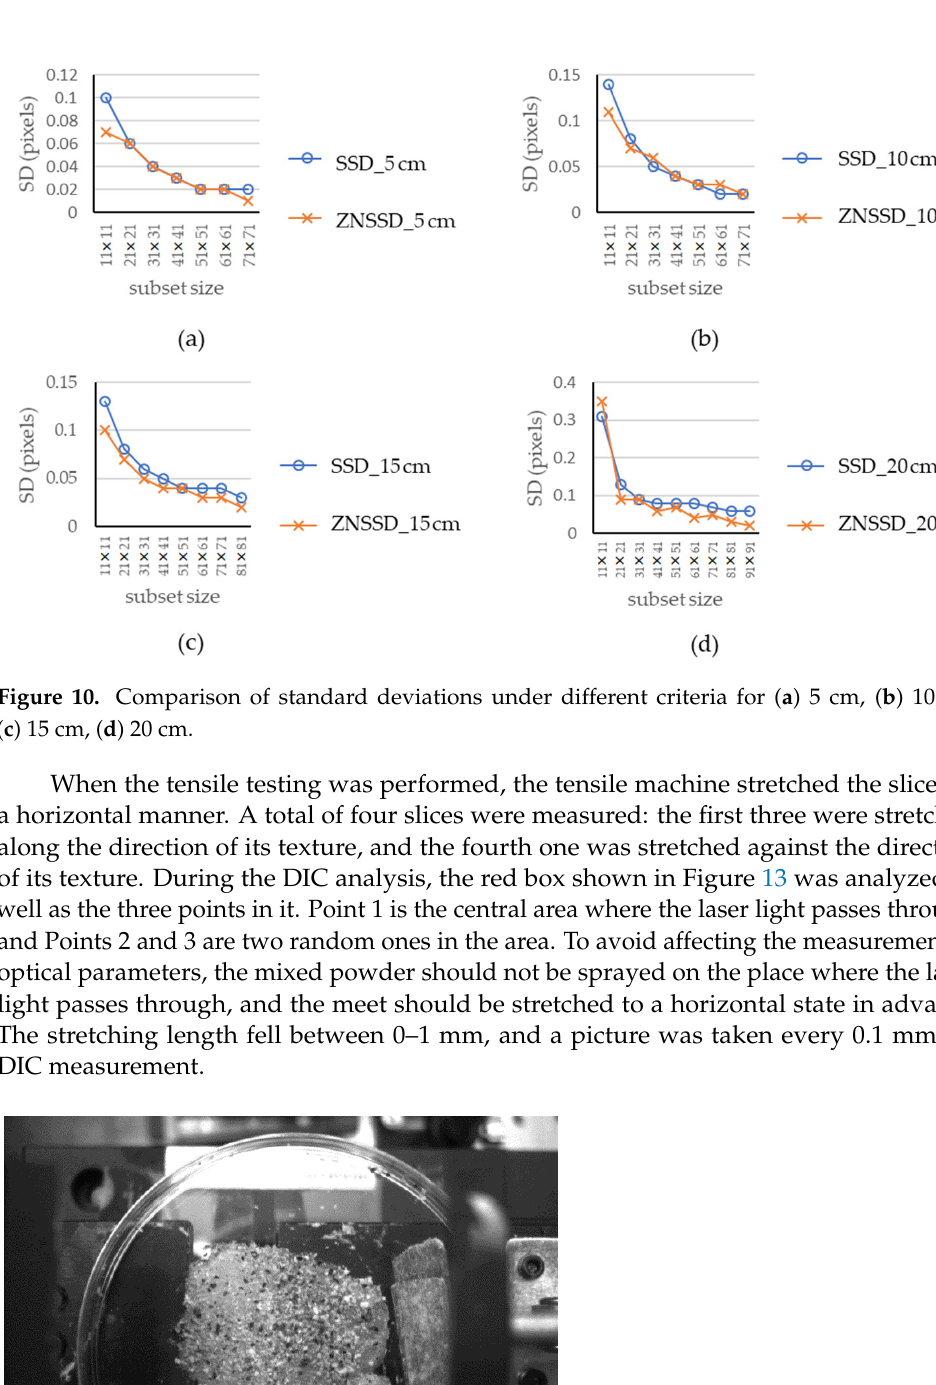
Figure 9. Comparison of average abs. errors under different criteria for ( a ) 5 cm, ( b ) 10 cm, ( c ) 15 cm, ( d ) 20 cm.